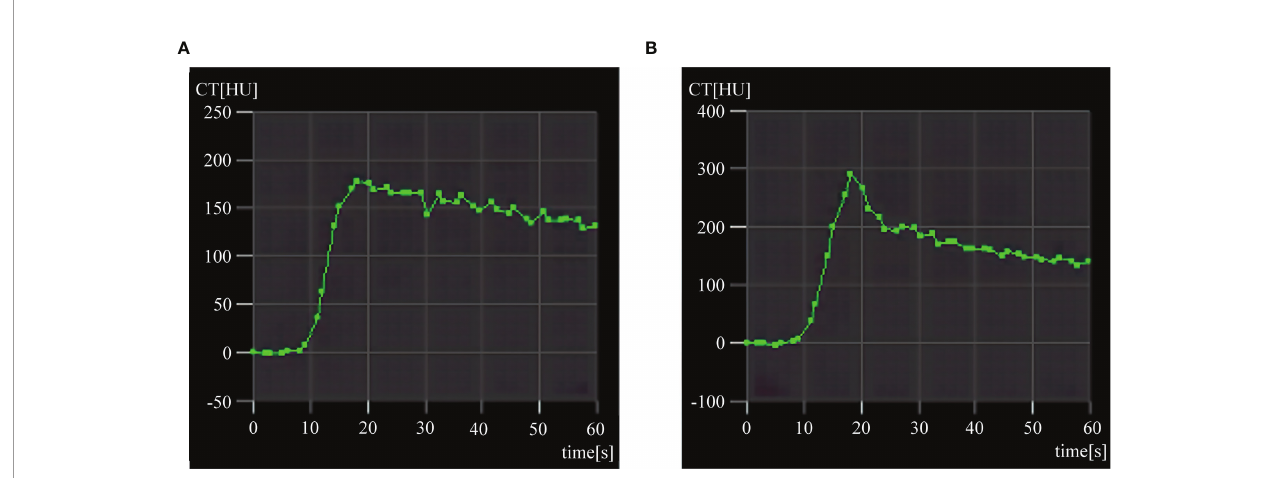
FIGURE 1 | Typical time-density curves (TDCs) of benign periablational enhancement (BPE) and viable tumor. (A) Typical speed-up and platform TDC of BPE after 3 days. (B) Speed-up and speed-down TDC of residual tumor.